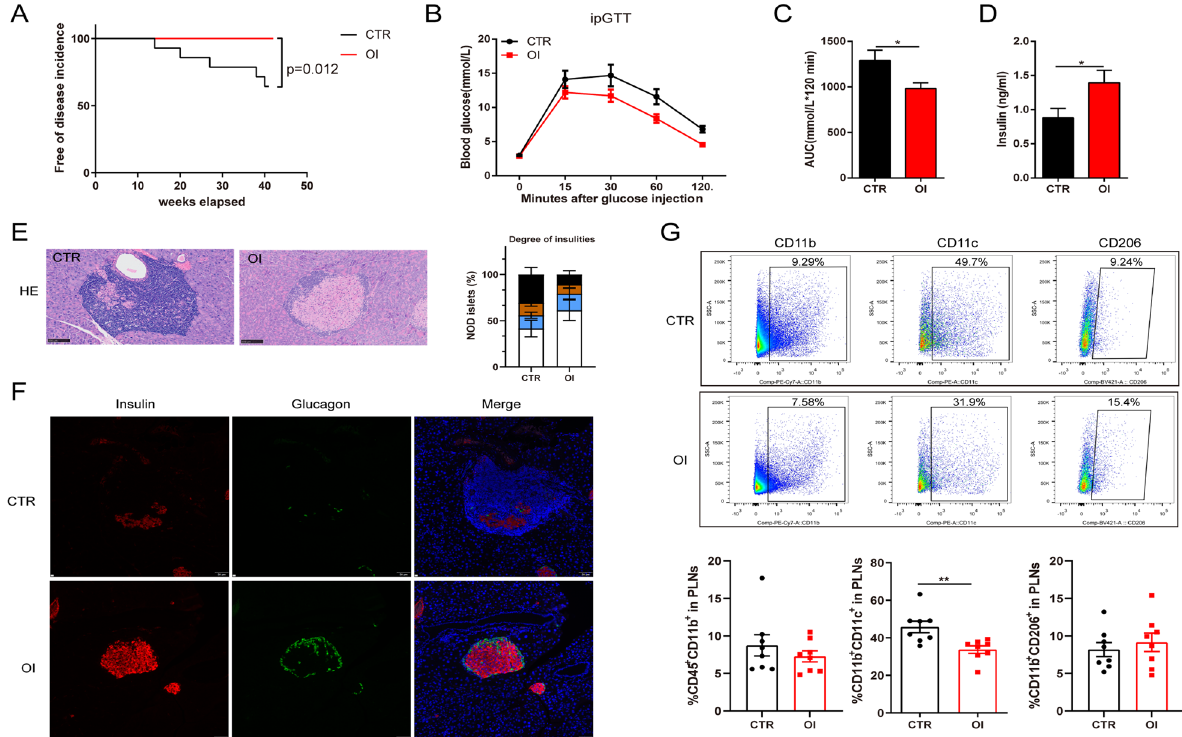
Fig. 3 OI treatment reduced diabetes onset in spontaneous non-obese diabetic (NOD) mice. A Kaplan–Meier survival curves demonstrating the percentages of diabetes-free NOD mice ( n 14–15 mice per group). B Week 22 ipGTT results of NOD mice. C The AUC of the ipGTT results in = B ( n 12–15 mice per group). D Serum insulin concentration of NOD mice ( n 12–13 mice per group). E Representative images of pancreatic = = histology evaluated by H&E staining ( n 11–12 mice per group). F Representative images of pancreatic immunofluorescence staining for insulin = (red), glucagon (green), and DAPI (blue). G Flow cytometry assessment and the proportion of CD45 + CD11b + , CD11b + CD11c + , and CD11b + CD206